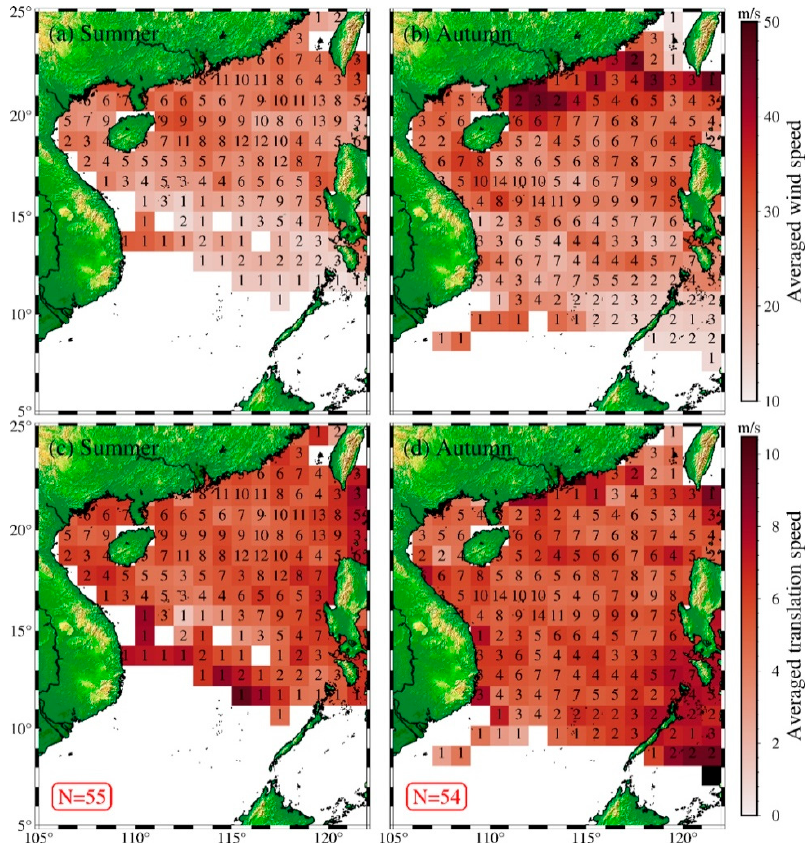
Figure 2. The distribution of average ( a , b ) wind speed and ( c , d ) translation speed for typhoons in ( a , c ) summer and ( b , d ) autumn. The corresponding numbers on meshes illustrate the frequency with which typhoons passed in the 15-year period. Blank means no typhoons were observed during the period.